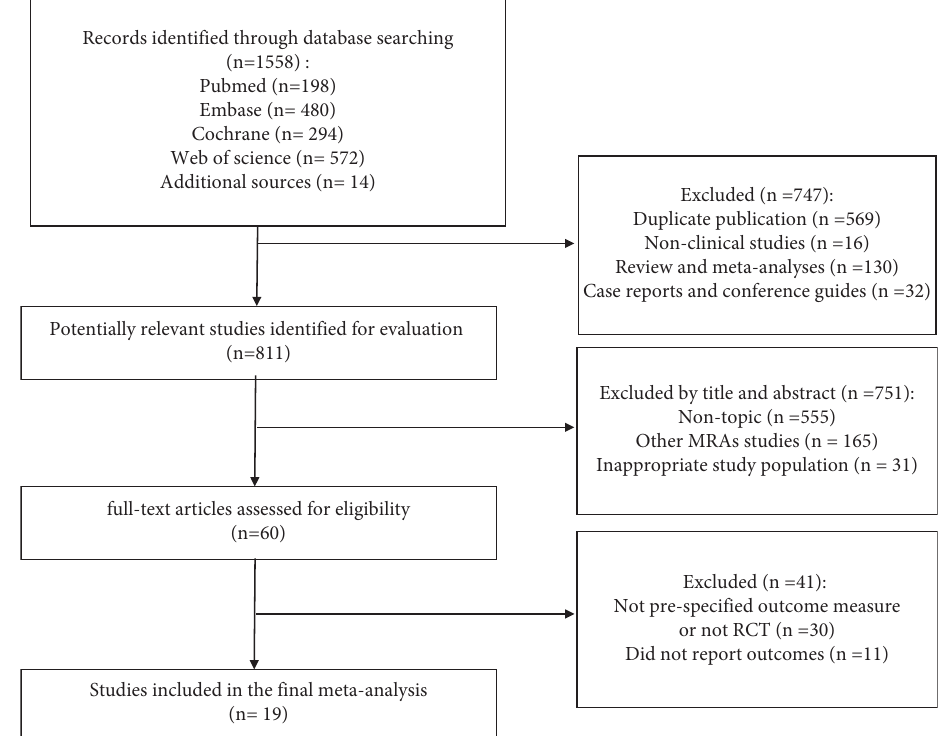
Figure 1: Flowchart of the literature search